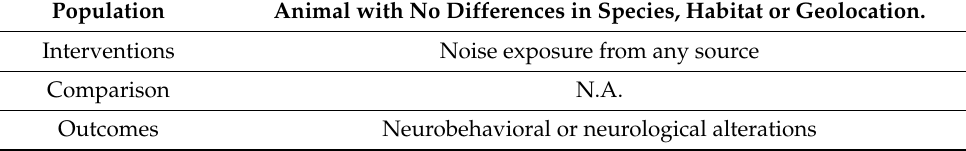
Table 1. PICO strategy. Population Animal with No Differences in Species, Habitat or Geolocation.